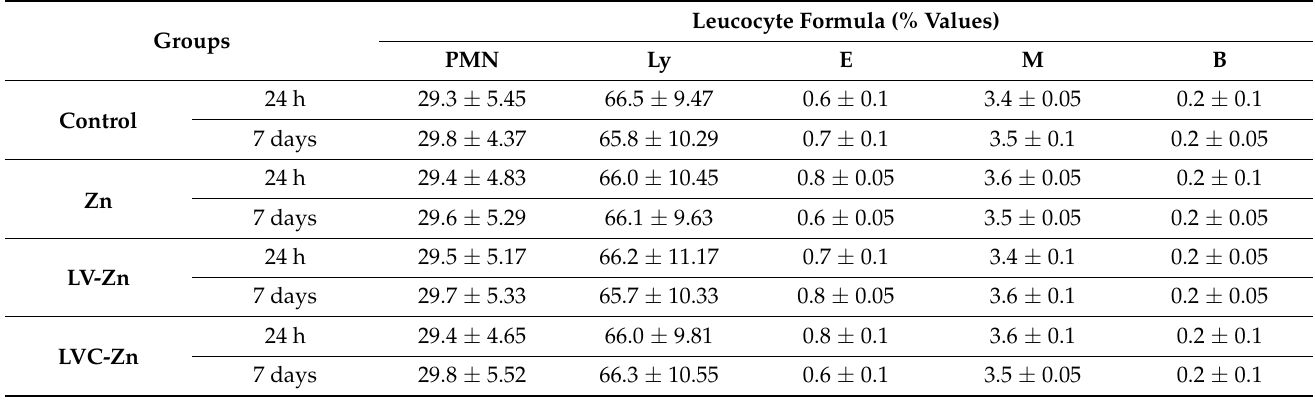
Table 1. The influence of LV-Zn and LVC-Zn on the percentages of the leucocyte formula elements. Values were expressed as mean ± S.D. of mean for 6 animals in a group. Leucocyte Formula (% Values) Groups PMN